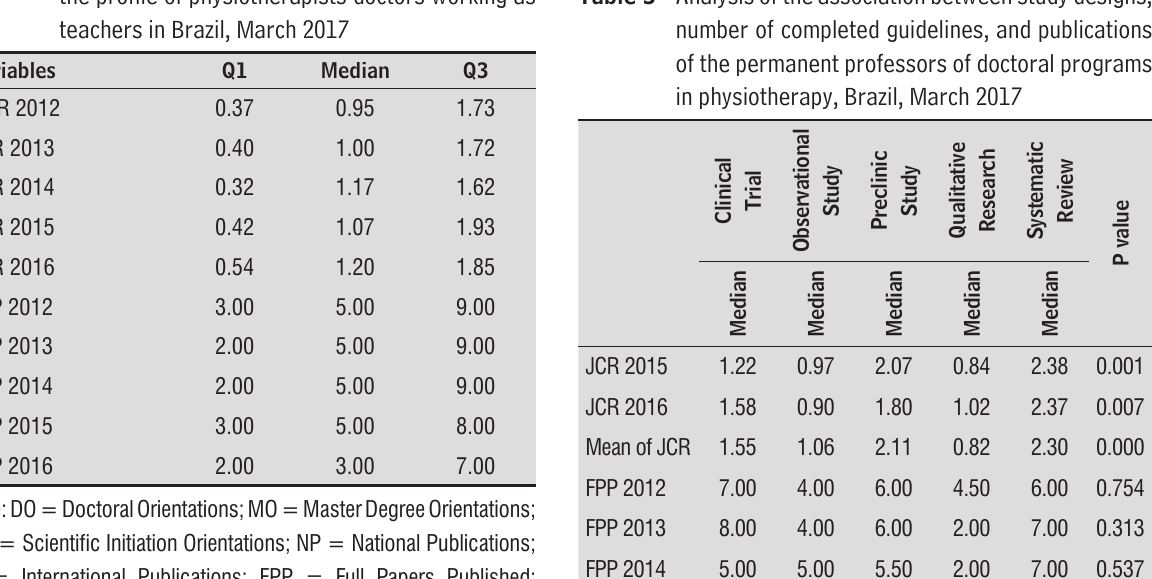
Table 3 - Analysis of the association between study